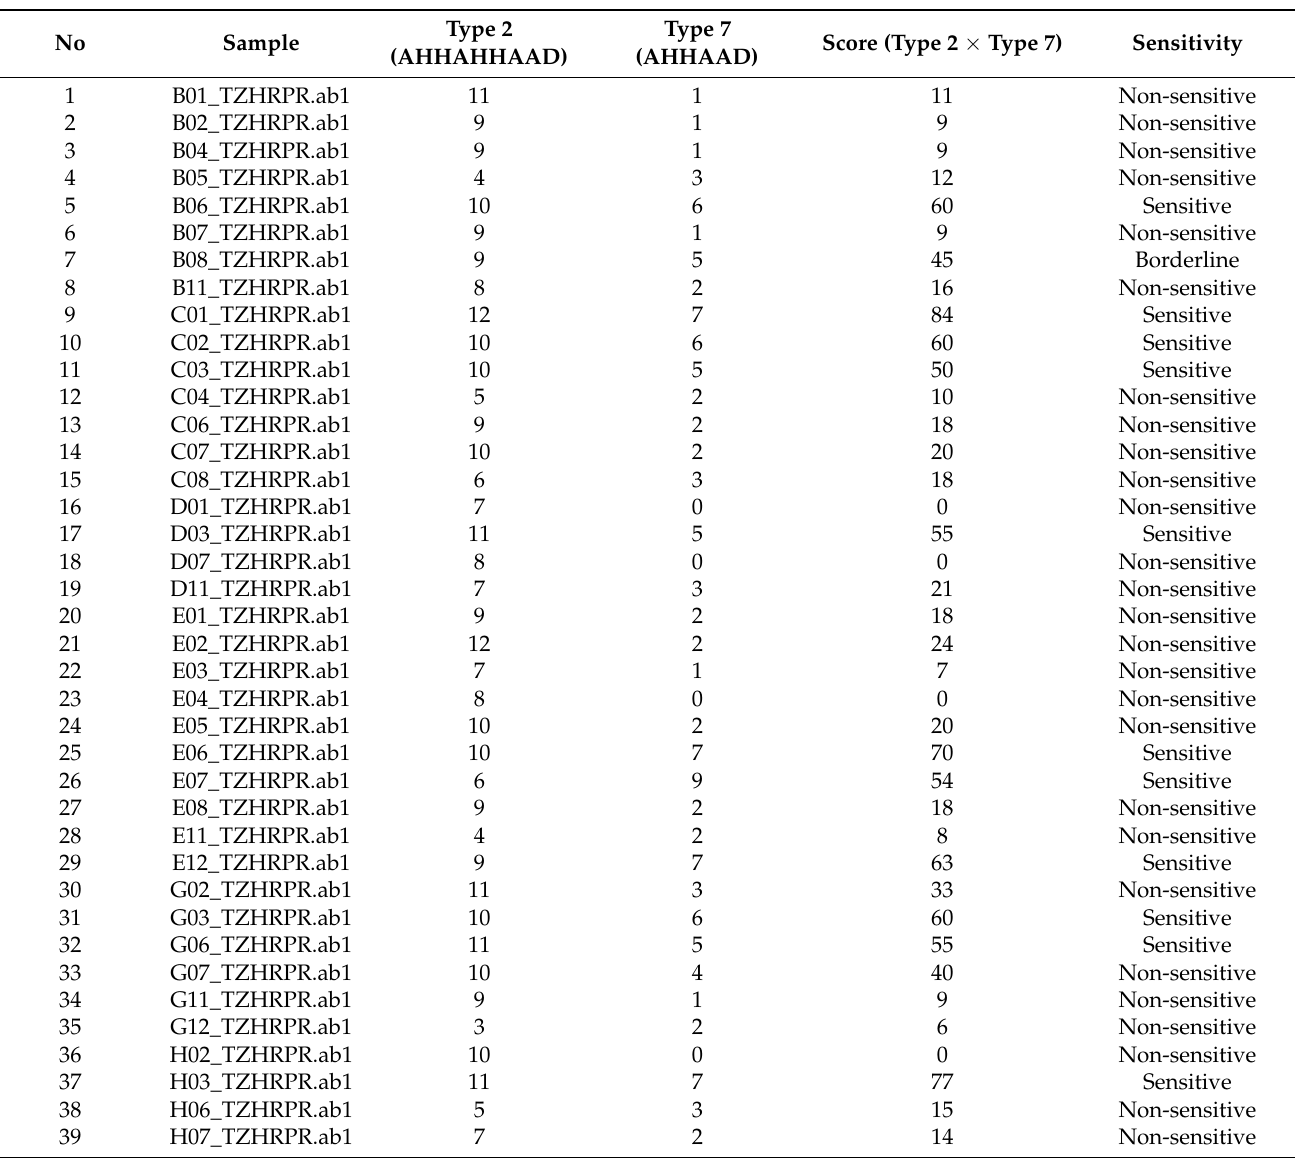
Table 3. Prediction of RDT sensitivity in field isolates of P. falciparum in north-eastern